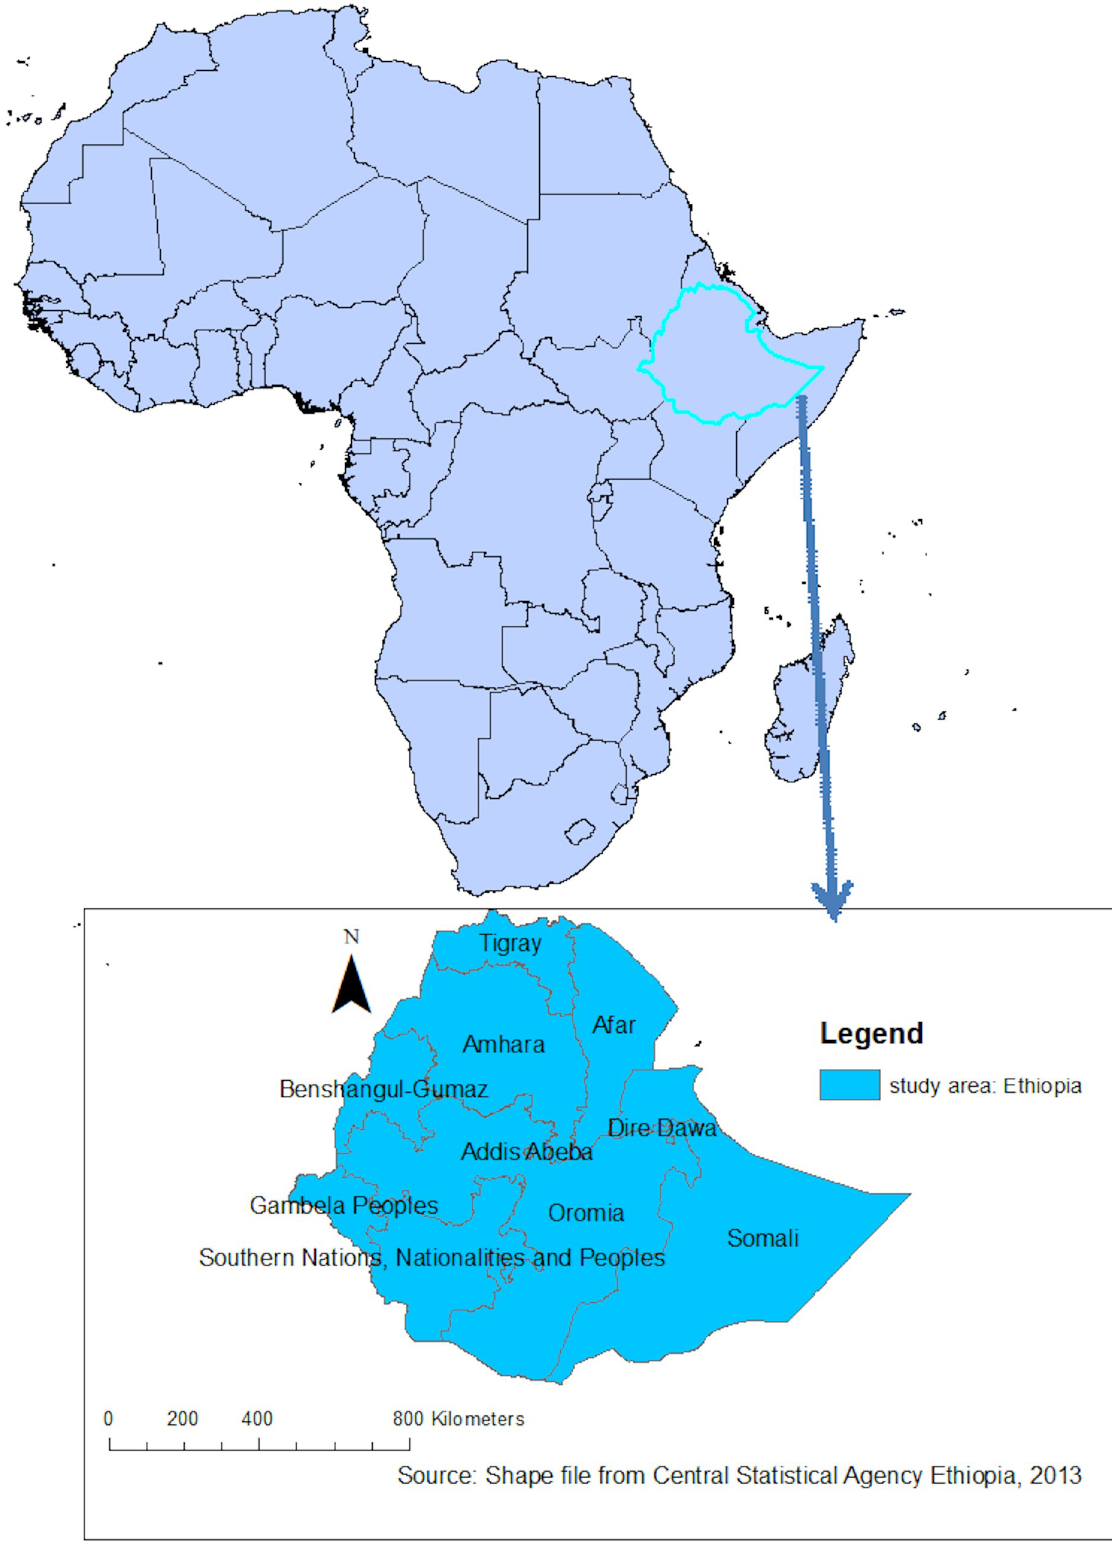
Fig 1. Map of Ethiopia where the three surveys were undertaken with nine regions and two administrative cities (Source: Shapefile from Central Statistical Agency, Ethiopia, 2013). https://doi.org/10.1371/journal.pone.0237147.g001 PLOS ONE | https://doi.org/10.1371/journal.pone.0237147 August 6,